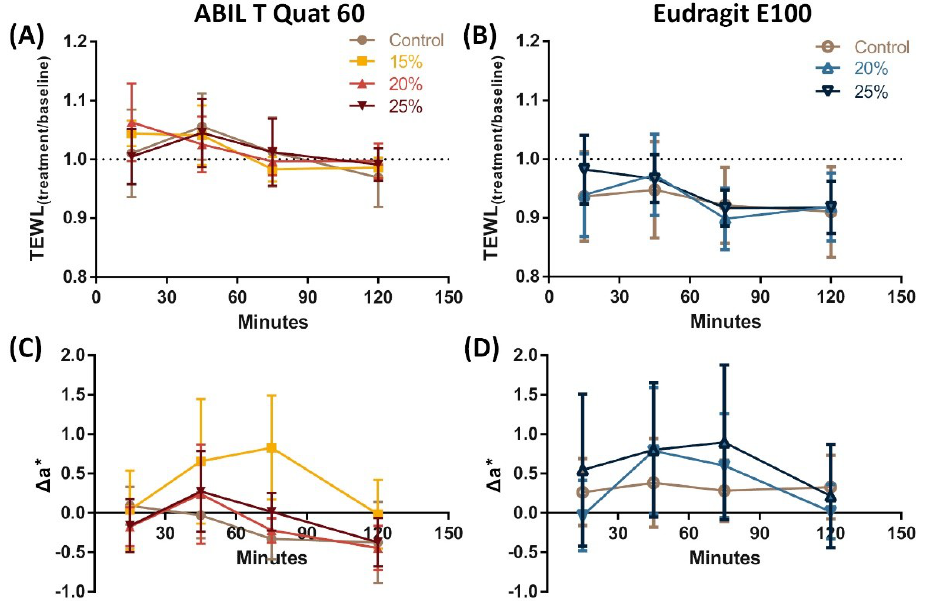
Figure 8. Evolution of TEWL ( A , B ) and skin redness (Δa*) ( C , D ) following application of polymeric film-forming systems to the forearm of healthy subjects: Films with ABIL ( A , C ) and films with Eudragit ( B , D ) ( A – D : No significant differences found between treatments and control by Two-way RM ANOVA; subjects = 5).